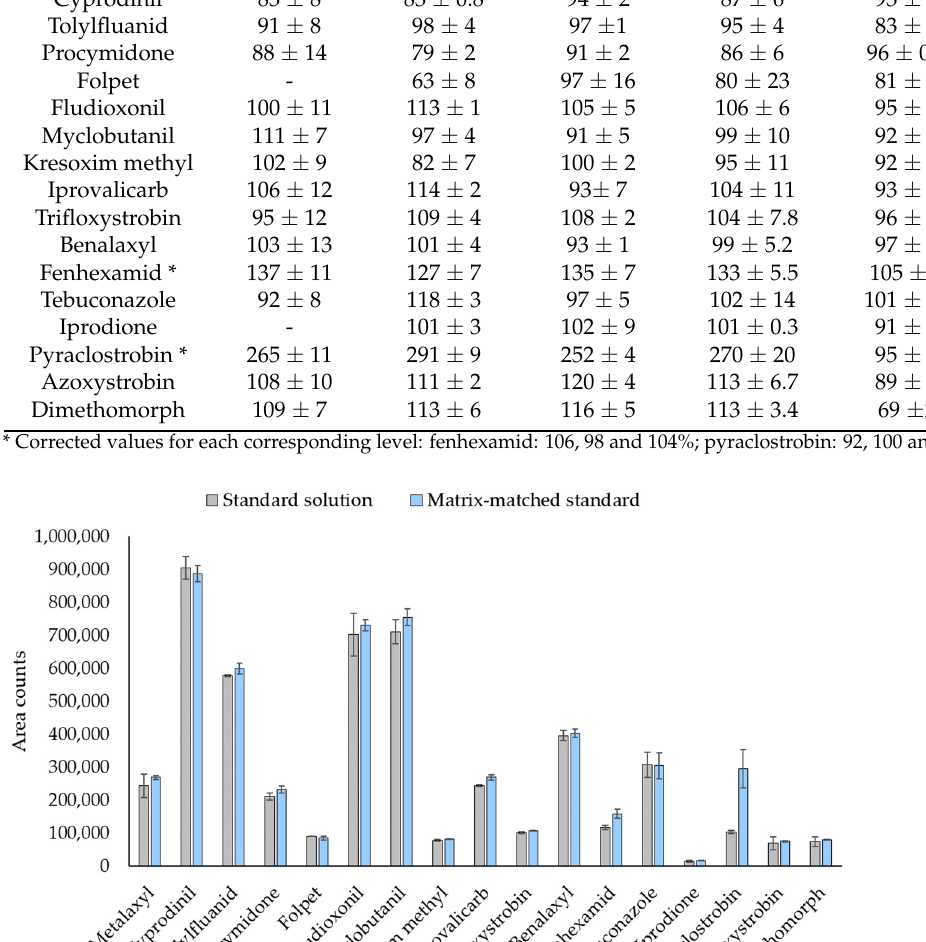
Figure 5. Fungicide responses for a standard solution and a matrix-matched standard at 10 μ g L − 1 .